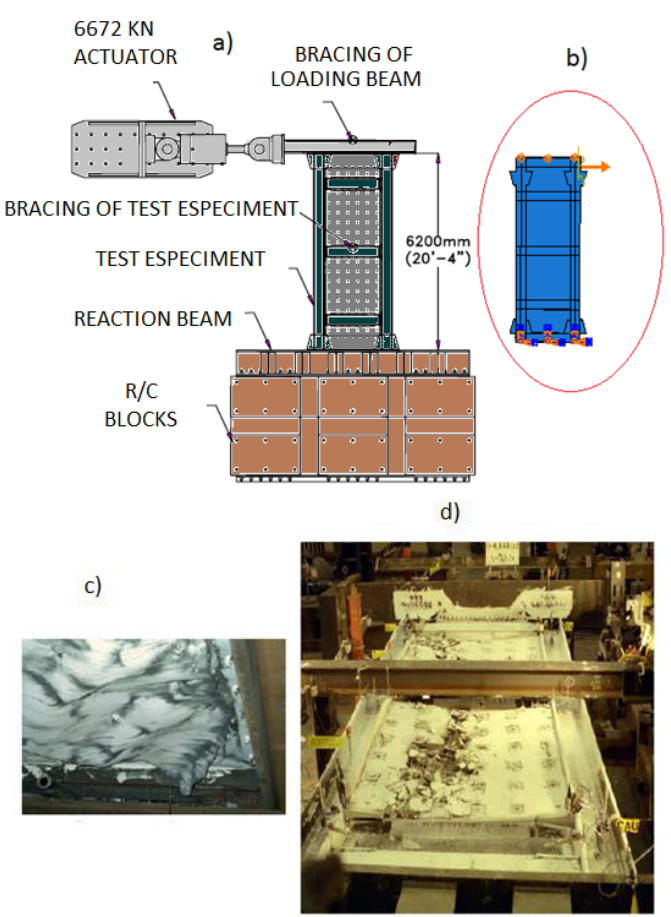
Figure 2. Test set-up and composite steel shear wall after testing ( a ) Experimental test set-up; ( b ) ABAQUS model; ( c ) steel shear plate after testing; ( d ) concrete plate.